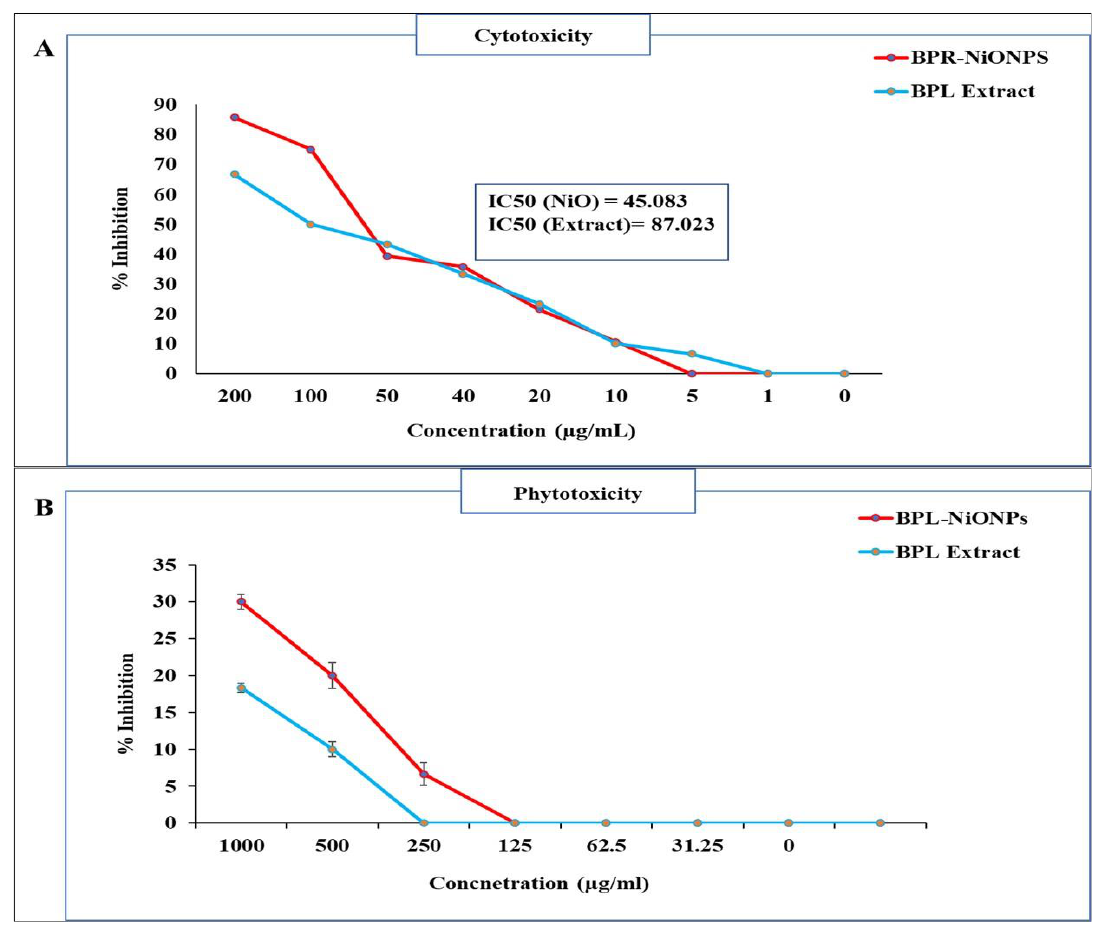
Figure 7. Cytotoxicity and phytotoxicity assays of BPL and BPL-NiONPs: ( A ) brine shrimp mortality test; ( B ) relative germination inhibition (%) of radish seeds. Obtained data are presented as mean ± standard deviation ( n = 3).